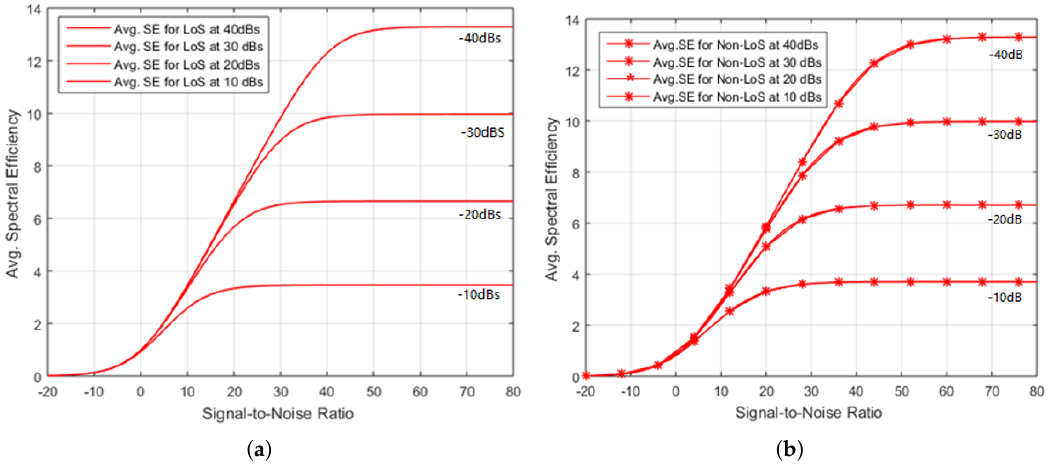
Figure 6. ( a ) Illustration of results for LOS by Increasing Transmit Power, ( b ) Illustration of results for NLoS by Increasing Transmit